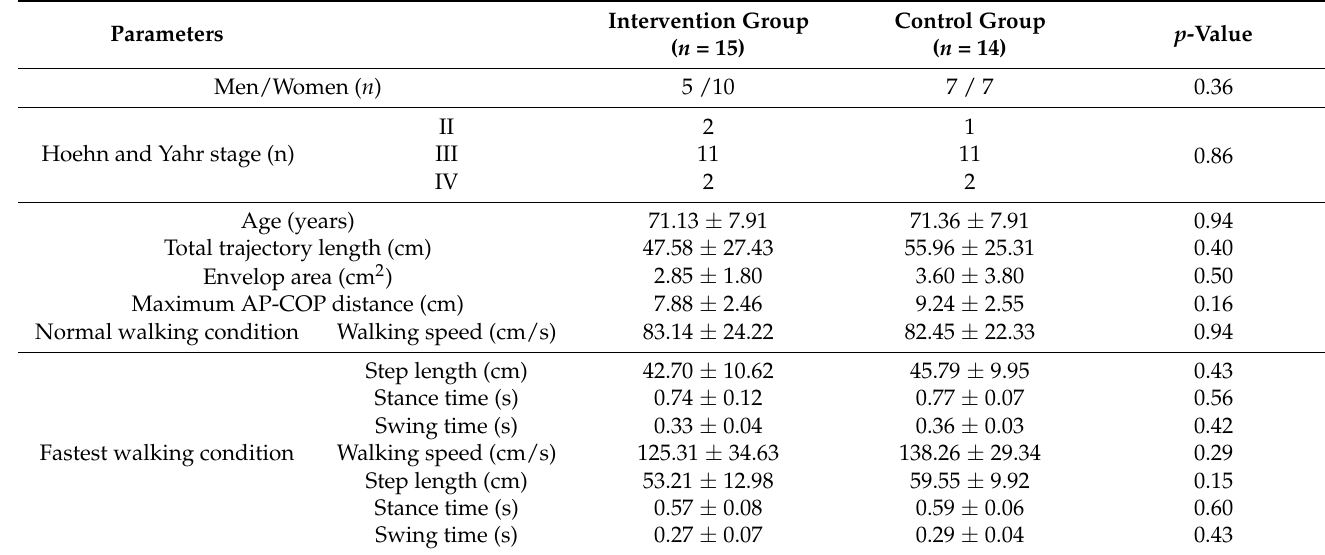
Table 1. Characteristics of the intervention and control groups.